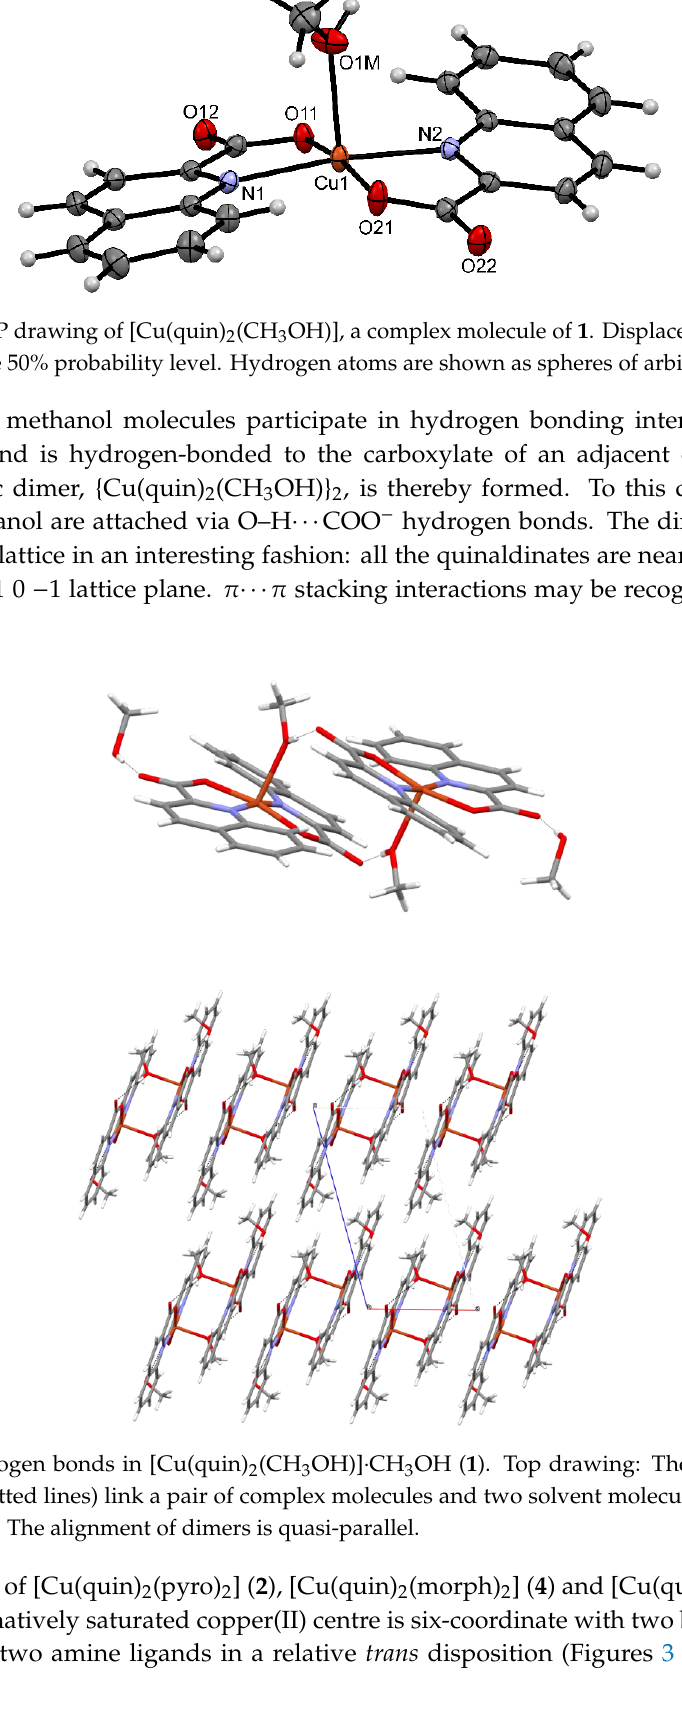
Figure 2. Hydrogen bonds in [Cu(quin) 2 (CH 3 OH)]∙CH 3 OH ( 1 ). Top drawing: The O – H∙∙∙COO – interactions (dotted lines) link a pair of complex molecules and two solvent molecules of methanol. Lower drawing: The alignment of dimers is quasi-parallel.